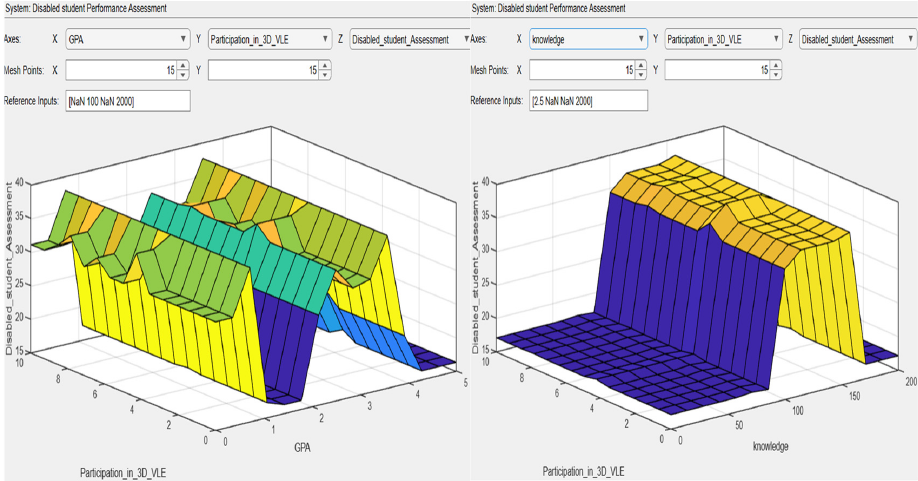
Figure 9. 3D VLE FIS input variables